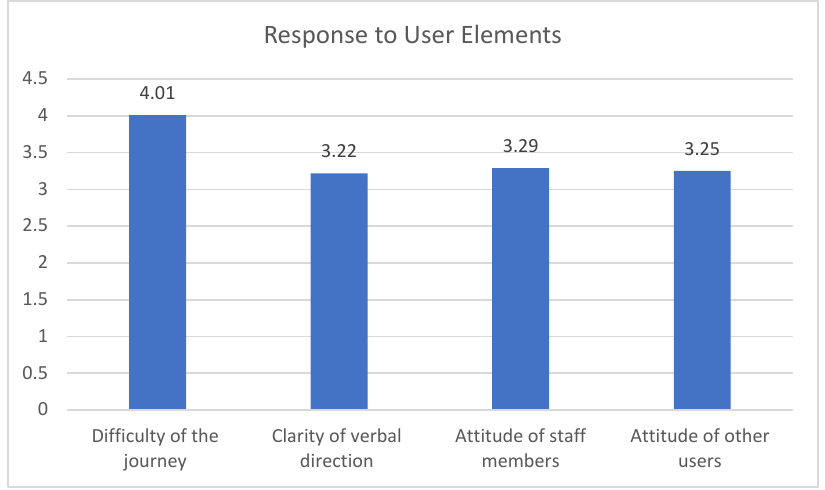
Figure 6. Mean responses to the user elements in the questionnaire.